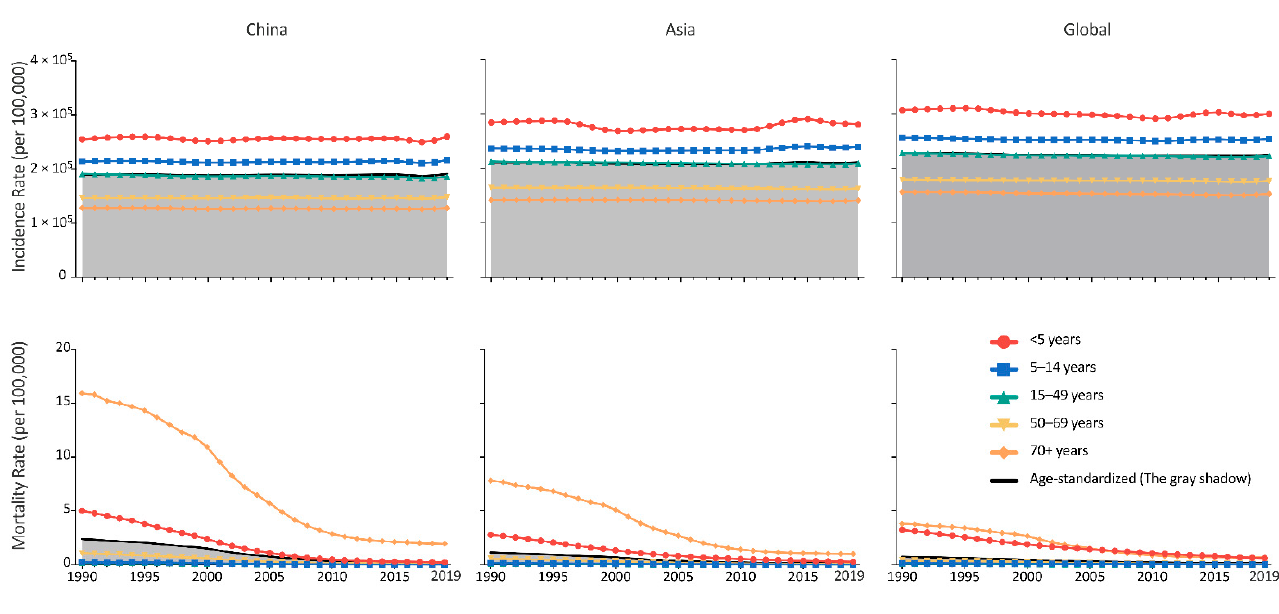
Figure 2. The incidence and mortality rate of upper respiratory infections by age group, from 1990 to 2019, in China, Asia, and the rest of the globe.